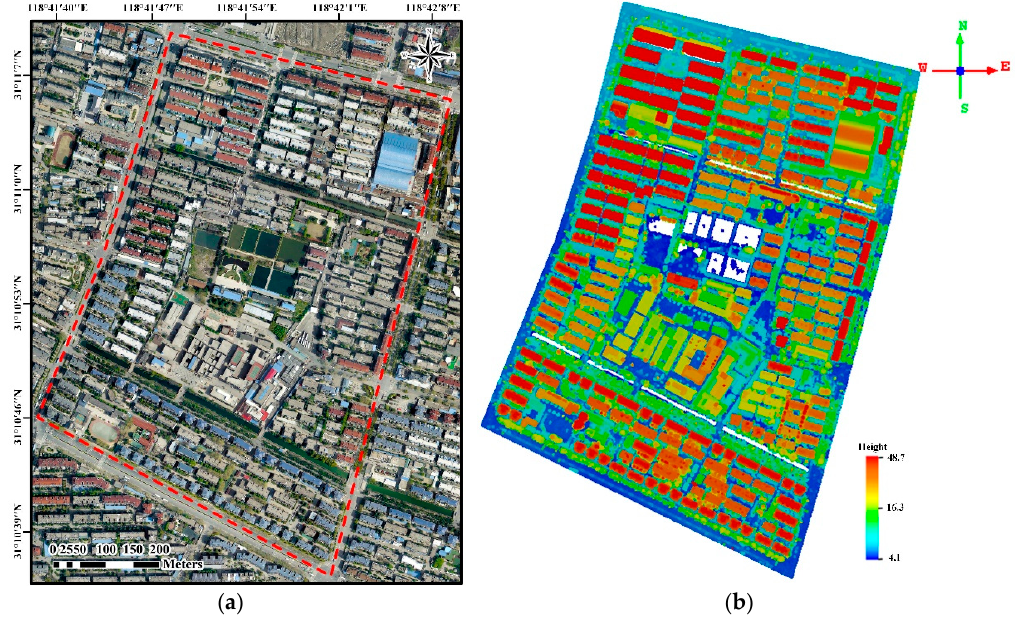
Figure 7. Experimental Region 2: ( a ) aerial orthophotos with 0.3 m resolution; and ( b ) airborne LiDAR data.